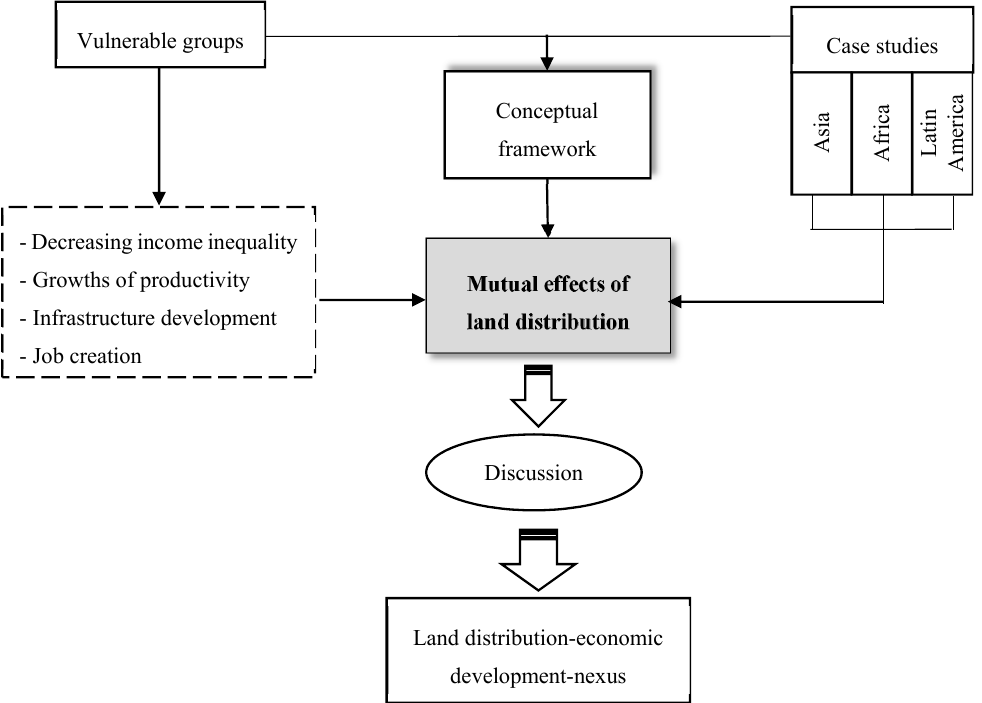
Figure 1. Conceptual framework of land distribution-economic development-nexus.